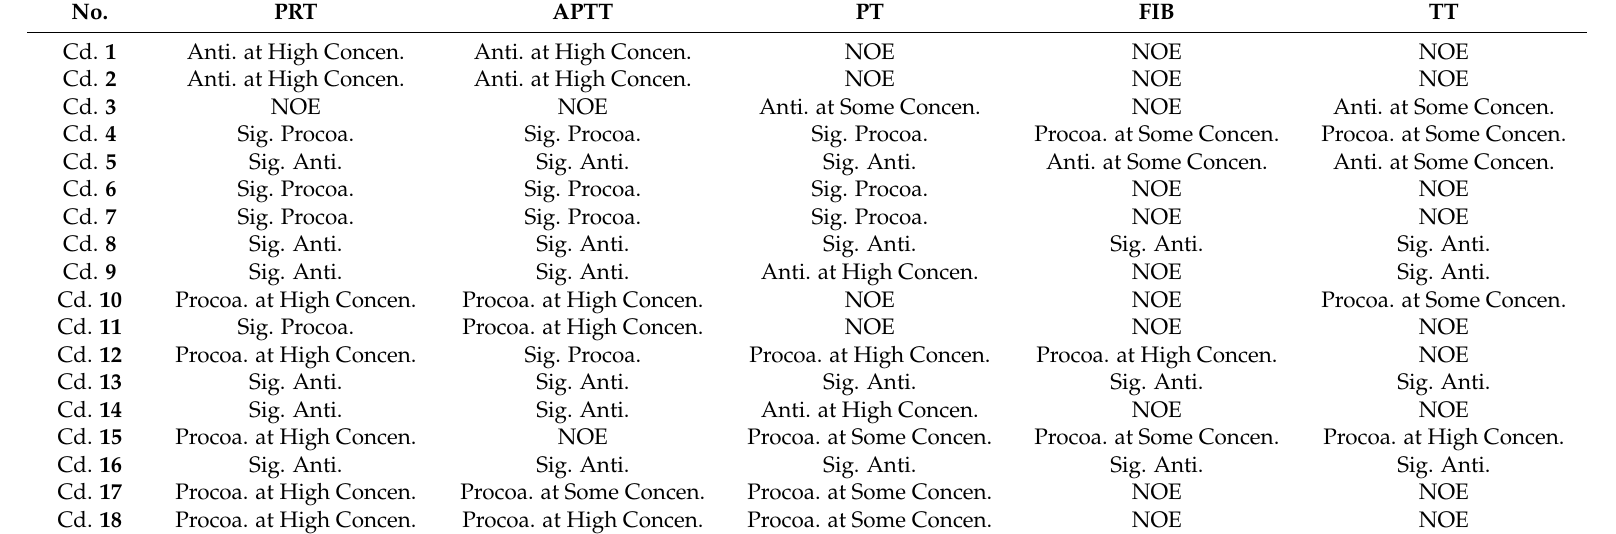
Table 9. Plasma recalcification, prothrombin, activated partial thromboplastin, fibrinogen, and thrombin time results of the phenolic acid derivatives. No. PRT APTT PT FIB TT Cd. 1 Anti. at High Concen. Anti. at High Concen. NOE NOE NOE Cd. 2 Anti. at High Concen. Anti. at High Concen. NOE Cd. 3 NOE NOE Anti. at Some Concen. NOE Anti. at Some Concen. Procoa. at Some Concen. Procoa. at Some Concen.